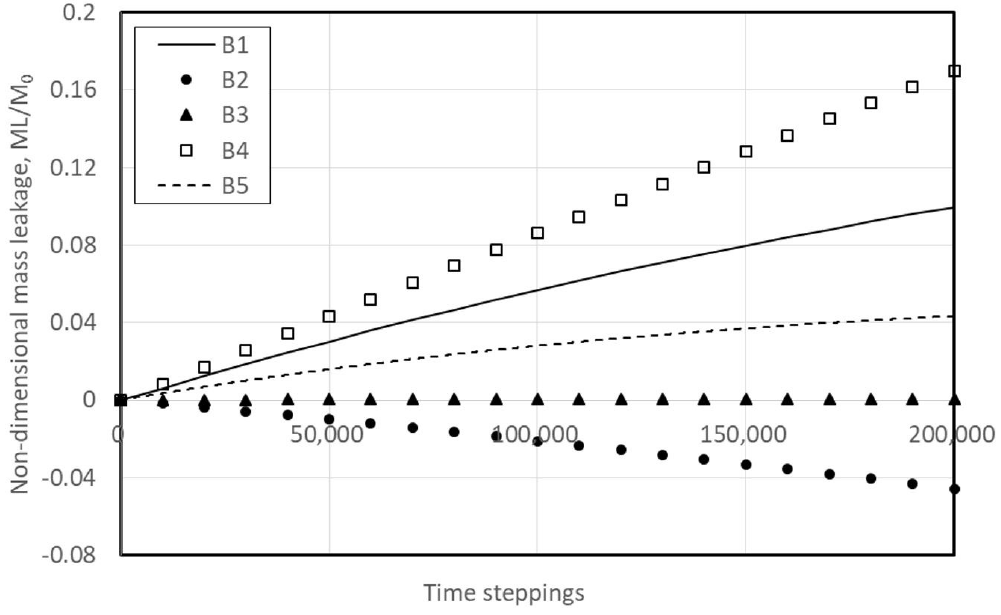
Figure 6. Non-dimensional ML variation with time along different